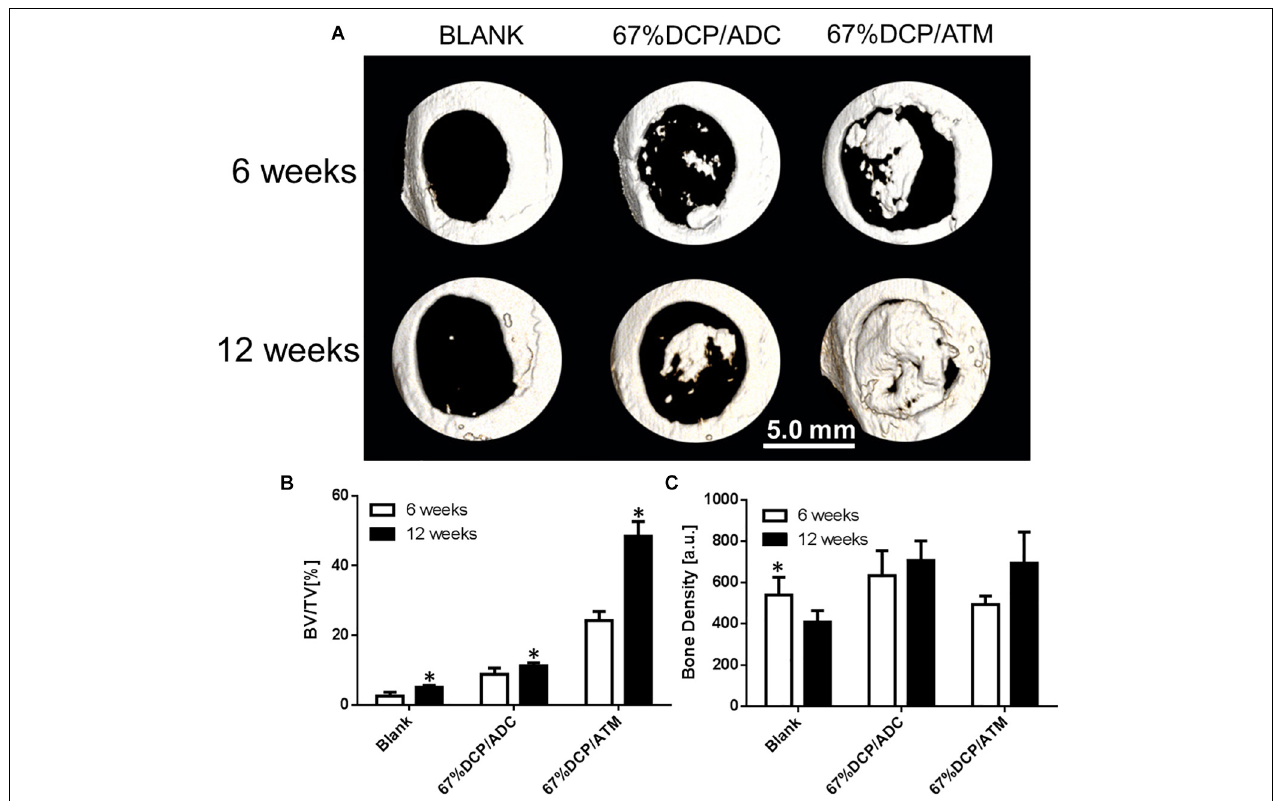
FIGURE 5 | Bone healing of rat calvarial defects using three groups of treatment: (A) Representative micro-CT images of calvarial defects of rats 6 and 12 weeks after surgery. (B) BV/TV measurement shows new bone formation with 67%DCP/ATM was 50% high than 67%DCP/ADC. (C) Bone density shows no significant differences between two types of scaffolds. ∗ Represent significant difference between 6 and 12 week ( p <